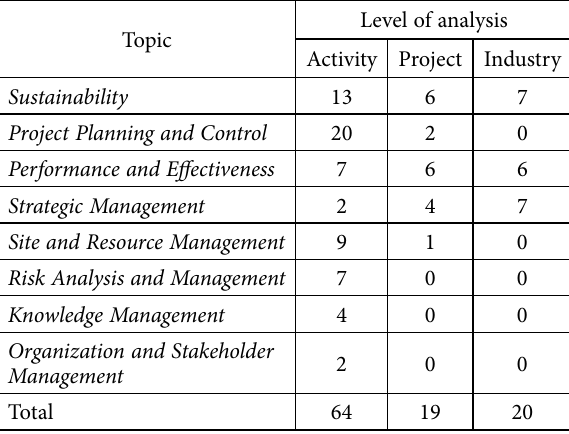
Table 3. Categories of research design in SDM-based papers